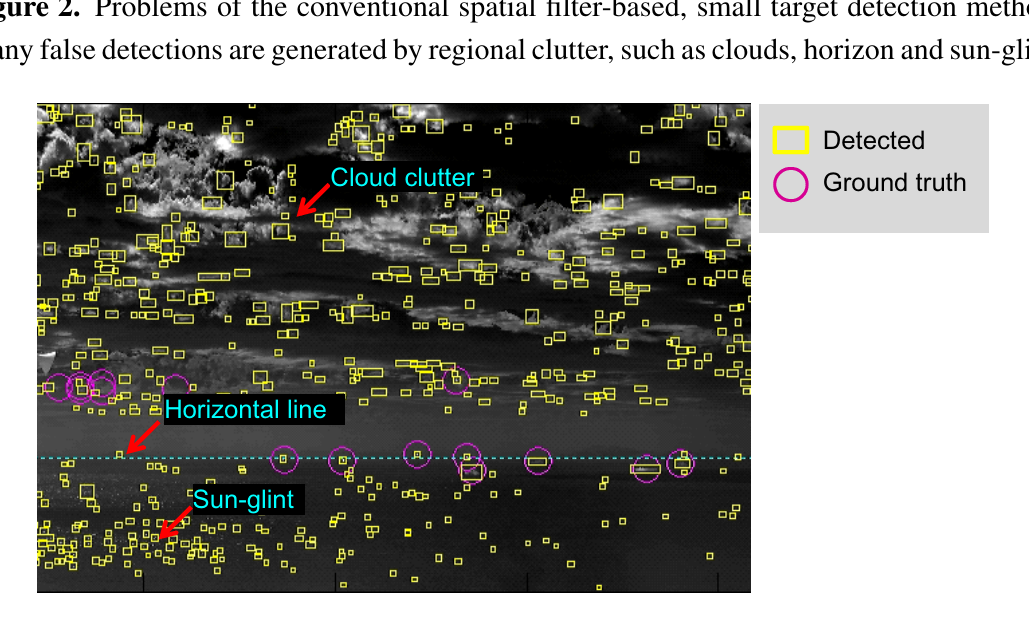
Figure 2. Problems of the conventional spatial filter-based, small target detection method. Many false detections are generated by regional clutter, such as clouds, horizon and sun-glint.